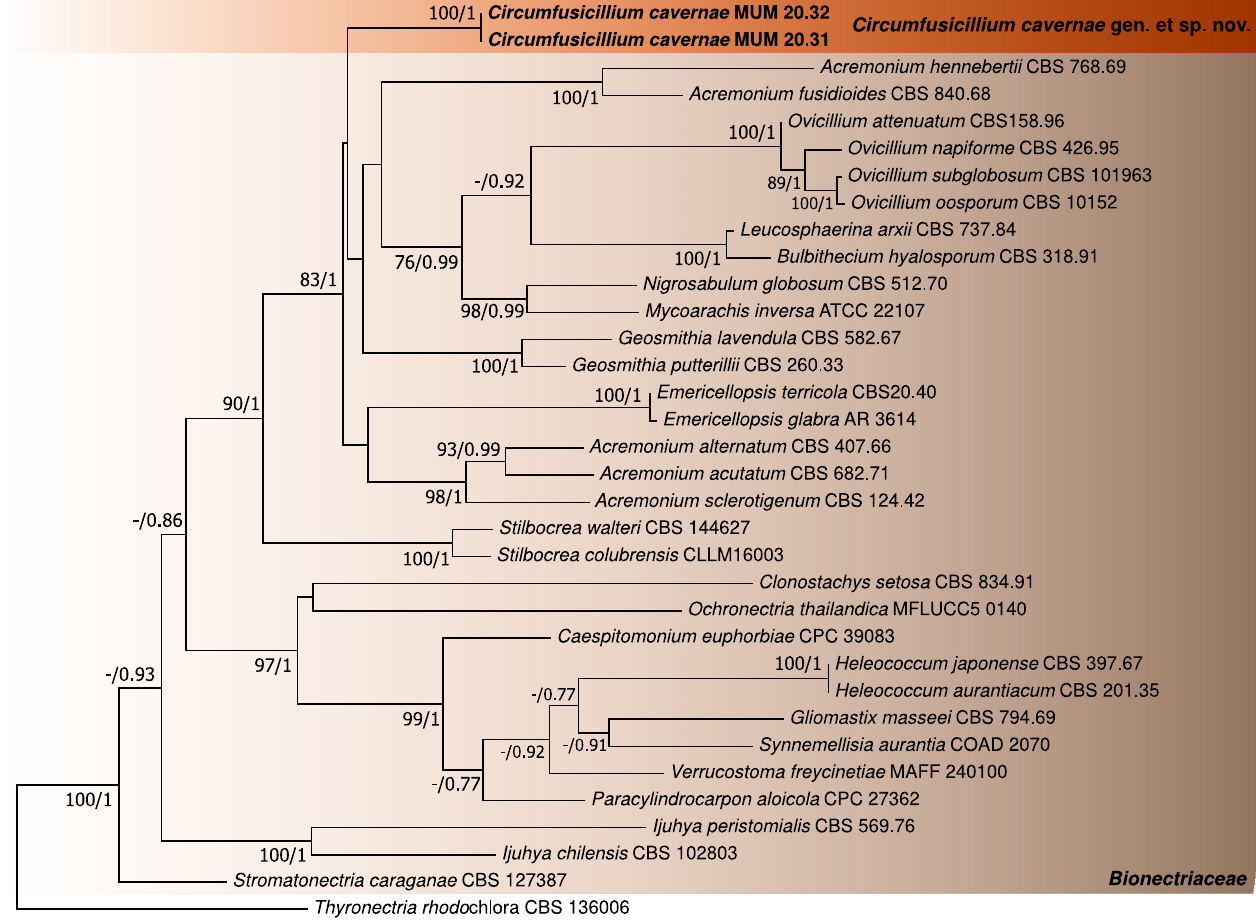
Figure 3. Phylogenetic trees obtained using the concatenated ITS and LSU reference Bionectriaceae sequences. The new taxa are indicated in black and bold . The scale bar indicates the number of substitutions per site, and the support values (>75% bootstrap values for Maximum likelihood and >0.75 for Bayesian MCMC posterior probabilities) are also shown.